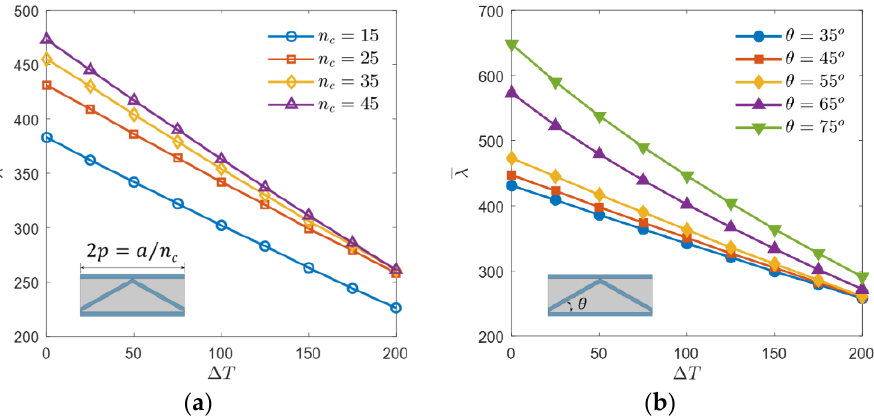
Figure 11. Effects of ( a ) number of unit cell and ( b ) inclined angle on dimensionless critical dynamic pressure against temperature change.